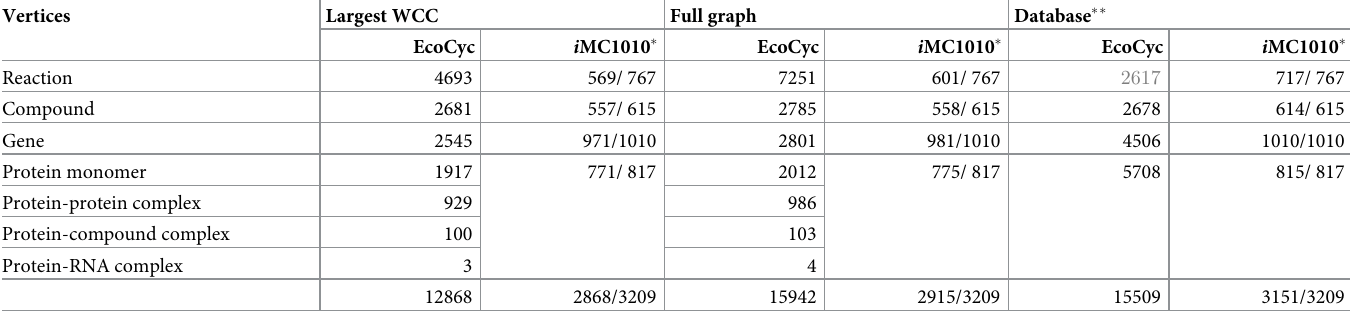
Table 1. Comparison of vertex composition and the coverage to the model from [11] of the integrative E. coli network (Largest WCC), the underlying full graph and the EcoCyc database (release 20.0). Vertices